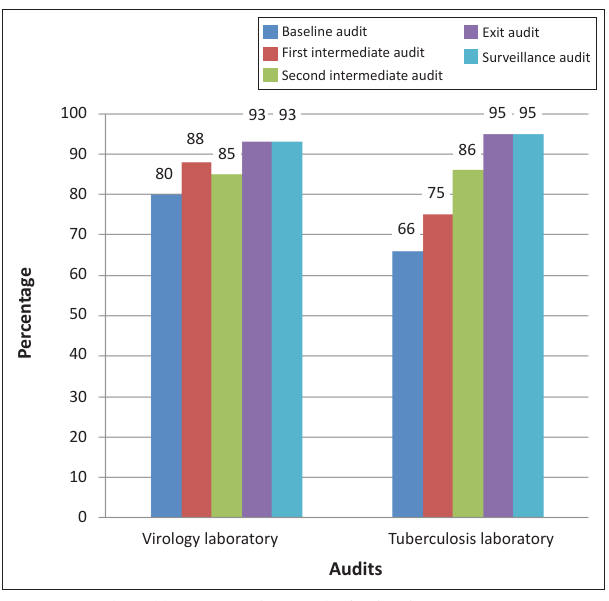
FIGURE 2: Comparison of performance of virology and tuberculosis laboratories over time using the WHO AFRO checklist.